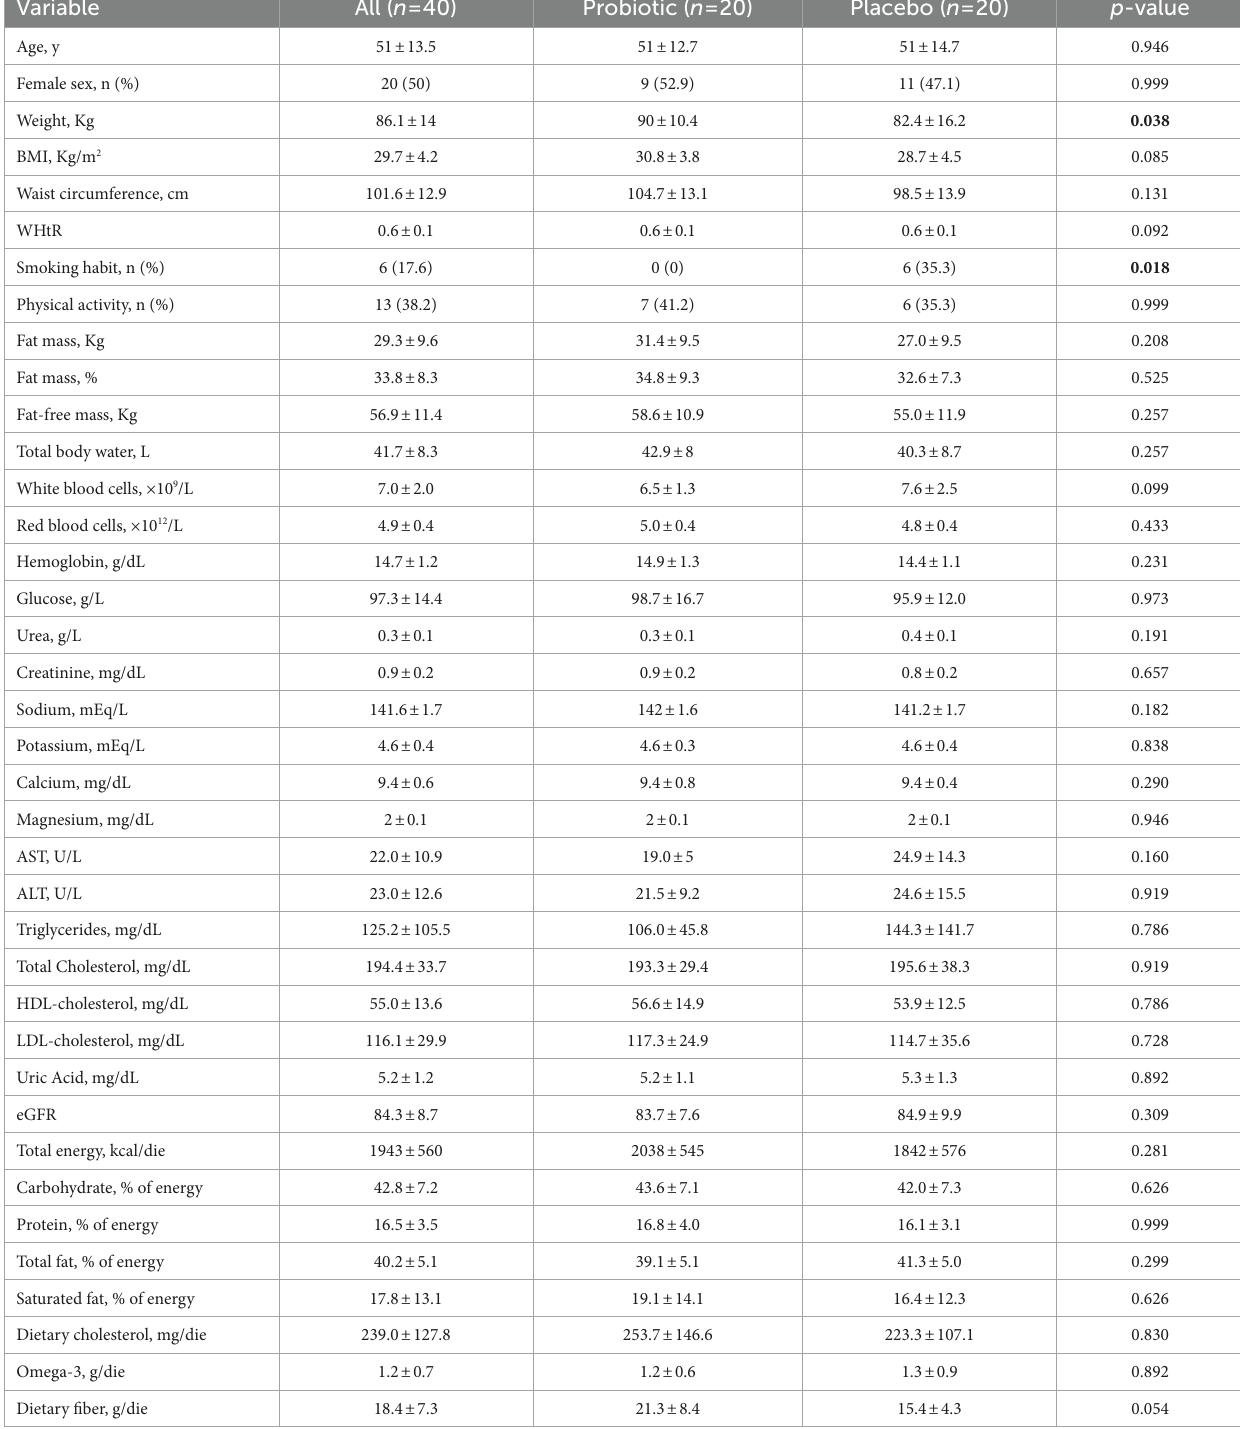
TABLE 1 Baseline characteristics of the study population according to the randomization.